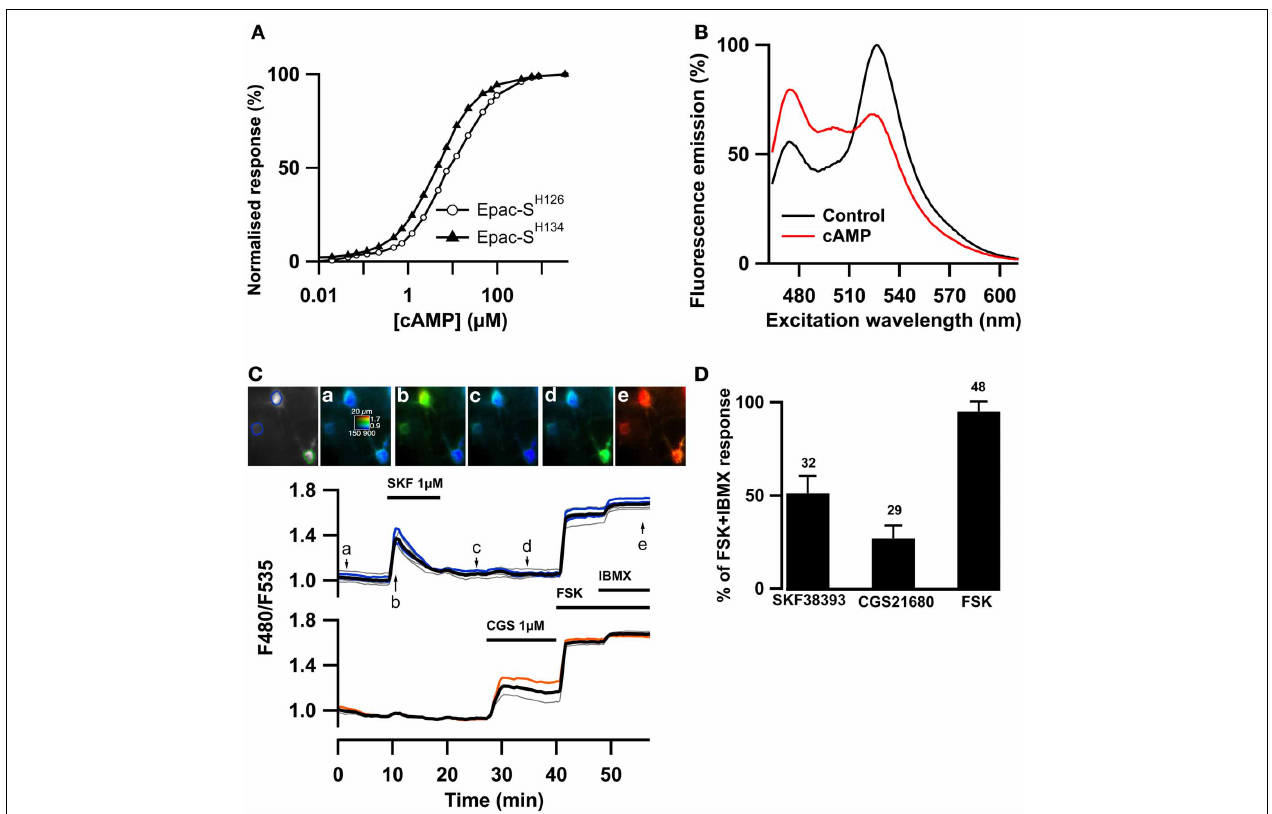
FIGURE 2 | The Epac-S H150 sensor reported large cAMP signals in D 1 and D 2 MSNs. The T Epac VV sensor (labeled Epac-S H126 ) was mutated to increase its sensitivity for cAMP, yielding Epac-S H134 ; representative dose-response curves for both sensors are presented in (A) . The acceptor was then changed for a cp174Citrine, yielding Epac-S H150 . The emission spectrum of Epac-S H150 in the absence and in the presence of saturating (100 µ M) cAMP is presented in (B) . (C) Medium spiny neurons (MSNs) in a mouse brain slice were transfected for expression of Epac-S H150 and imaged with wide field microscopy. Images show the raw fluorescence at 535nm (left, in gray scale) and the ratio (in pseudocolor) indicating the ratiometric change of Epac-S H150 reporting the binding of cAMP, at the times indicated by the arrows on the graph below. Each trace on the graph indicates the F480/F535 emission ratio measurement on regions indicated